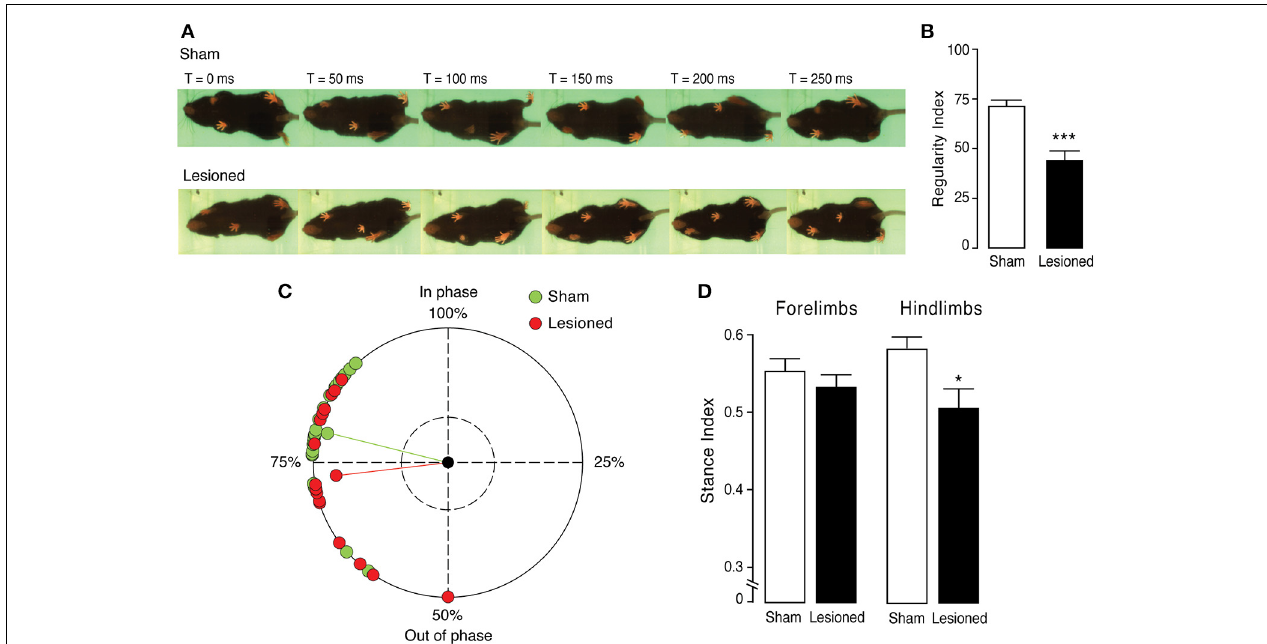
FIGURE 1 | Disruption of step cycle regularity in 6-OHDA-lesioned mice. Gait dynamics and pattern of motor coordination during locomotion were analyzed in sham ( n = 22) and 6-OHDA-lesioned (Lesioned) ( n = 17) mice. (A) Representative images of a complete step cycle (250ms), shown in six consecutive frames taken every 50ms, performed by a sham (upper) and a 6-OHDA-lesioned (bottom) mouse. (B) Bar graph showing the regularity index (expressed as percentage of correct step sequences over total number of step cycles) in sham and 6-OHDA-lesioned mice. (C) The coupling interval (expressed in percent) of diagonal limbs for each sham and 6-OHDA-lesioned mouse is represented in a circular graph, which